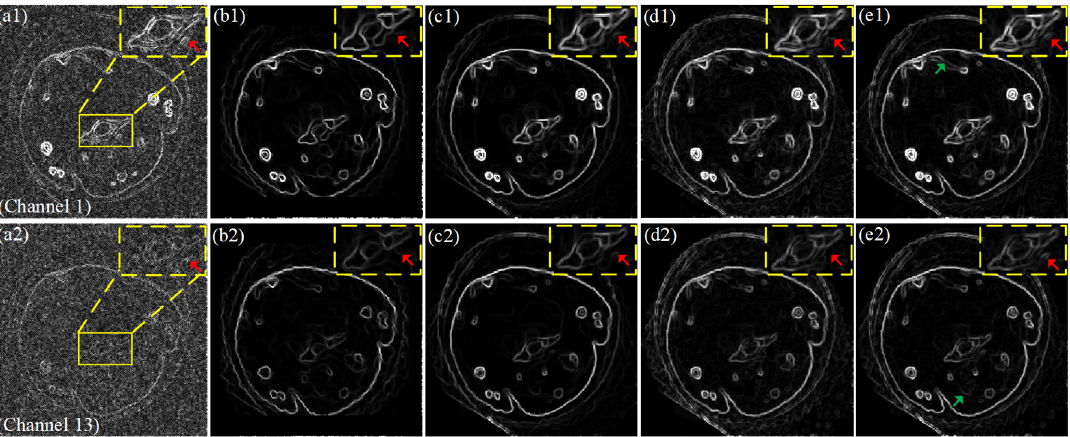
Figure 10. The gradient images from 60 projections. The first row is the first channel and the second row is the 13th channel. The first column is an image reconstructed from full projections using the FBP algorithm ( a ). Other columns are TV ( b ), TV + LR ( c ), TDL ( d ), and our algorithm ( e ). The display windows are [0, 0.02] cm − 1 .